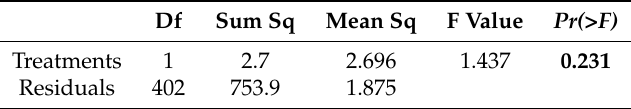
Table 6. ANOVA table of the statistical